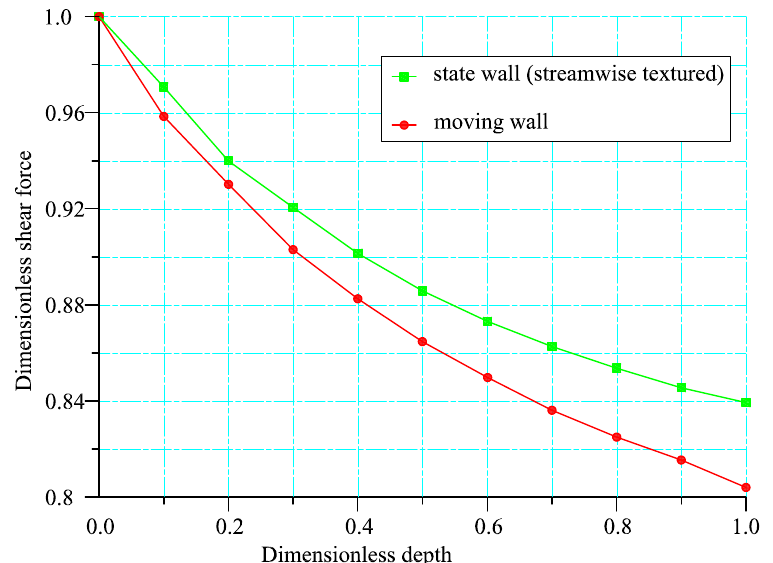
Figure 9. Influence of dimensionless depth of microtexture on wall shear force in streamwise texture